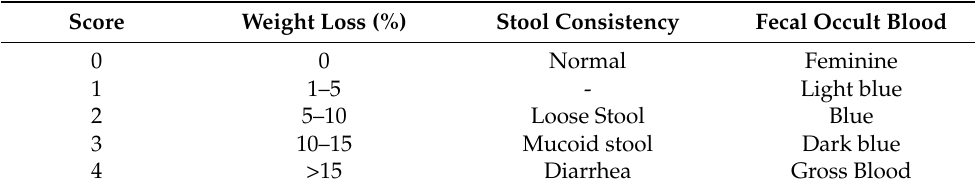
Table 1. The calculation method of disease activity index of all